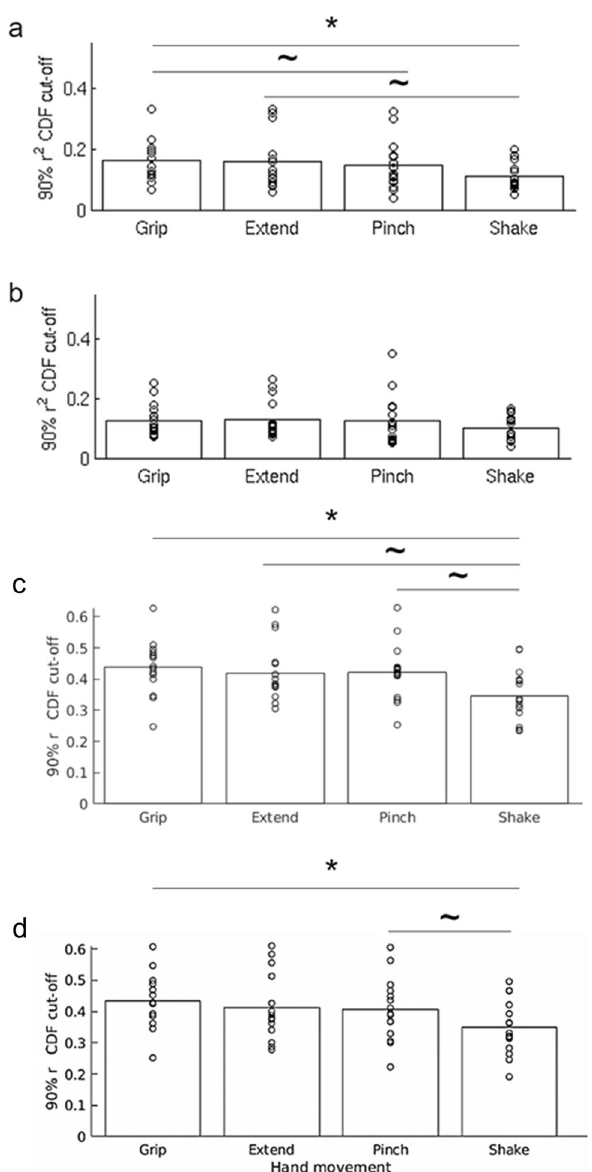
Figure 6. (a) r 2 cut-off values of the four different hand movements’ spatio-temporal patterns in the pre-task rest data. There was a significant main effect of movement (F(3,42) = 5.36, p = 0.0032) in a repeated measures ANOVA. Grip had the highest cut-off value (0.165) indicating that this pattern was the one most represented in the pre-task spontaneous activity. The lowest cut-off value was that of the Shake condition (0.11), indicating that it was the one least represented in the pre-task data. Only the difference between the Grip and the Shake conditions was significant following a correction for multiple comparisons (* t(14) = 3.66, p = 0.0026). The comparisons of Extend (0.159) vs Shake and Grip vs Pinch (0.145) were significant before correction but did not survive correcting for multiple comparisons (~ t(14) = 2.485, p = 0.026, and t(14) = 2.21, p = 0.044, respectively). (b) r 2 cut-off values in the post-task rest data using the spatio-temporal patterns. No significant differences were found in the post task data in terms of r 2 values of the different conditions. (c) The main analysis was repeated considering r values (instead of r 2 values) for the computation of the 90th cut-off of the CDF, and (d) inverting r values (multiplied by -1) – refer to the text for